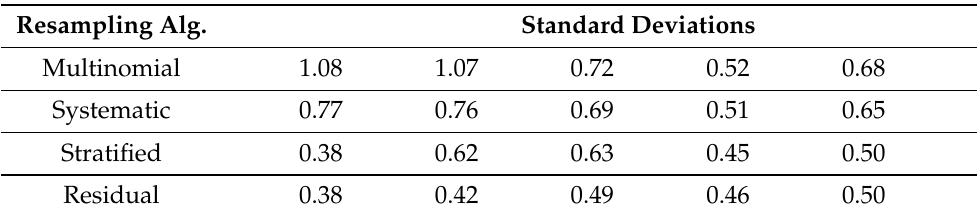
Table 3. Standard deviation of the number of times each of the samples is selected in a test containing 100,000 trials (weights 0.366, 0.354, 0.119, 0.058, 0.102). Resampling